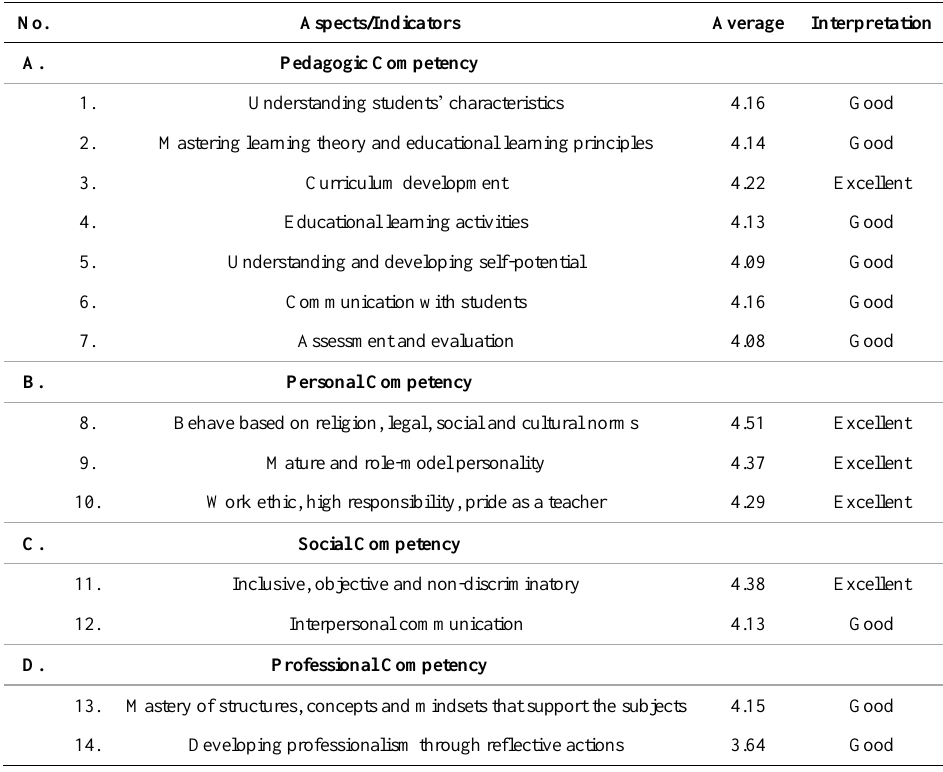
Table 1. Result of analysis phase